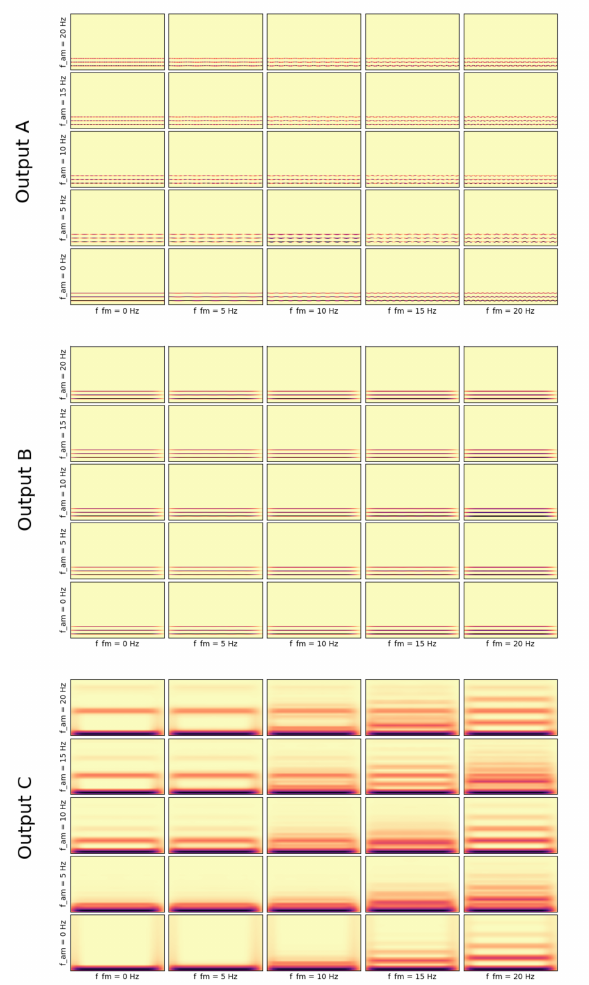
Figure 6. Example output of the interactive